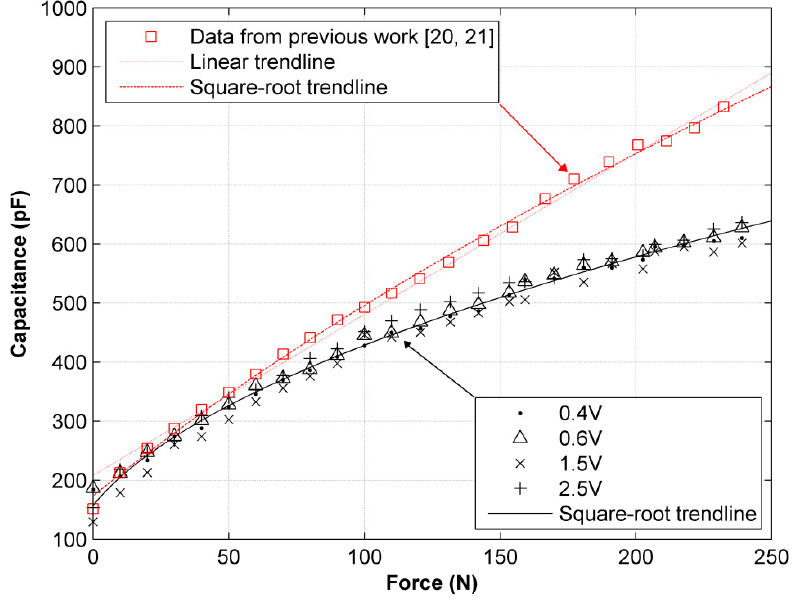
Figure 10. Sensor capacitance, C sourcing